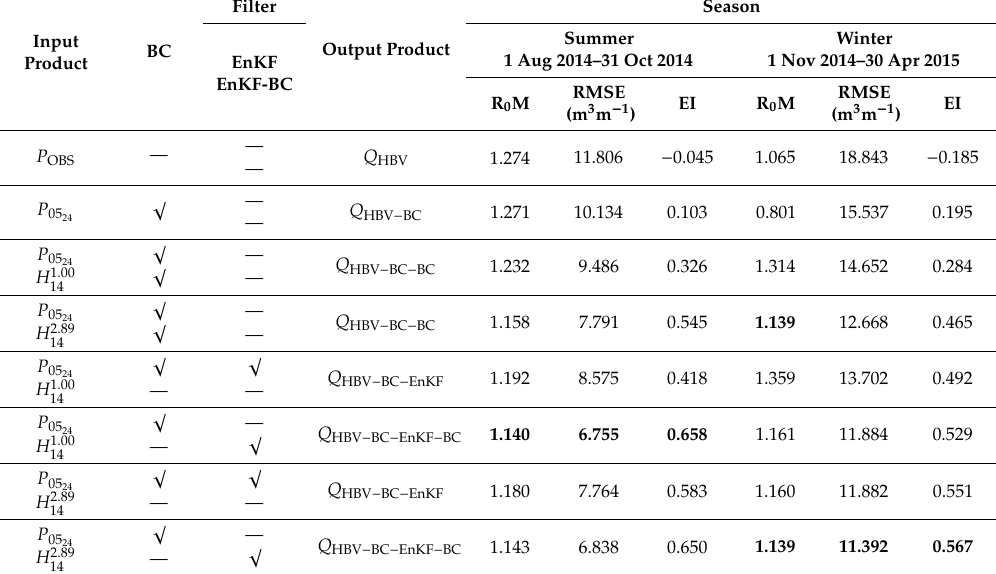
Table 3. Accuracy of the HBV model in estimating stream flow based on observed precipitation, and precipitation and soil moisture-related H-SAF products after BC and with filtering the soil moisture H-SAF products using the ensemble Kalman filter (EnKF) and EnKF-BC (ensemble Kalman filters without and with bias correction); R 0 M (ratio of means), RMSE (root mean squared error), and EI (Nash-Sutcli ff e e ffi ciency